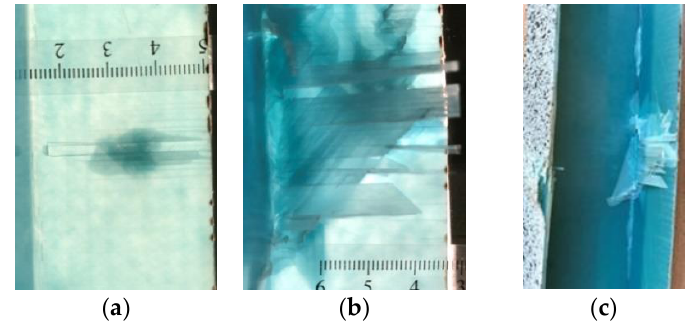
Figure 5. Impact damage before ( a ) and after ( b ) bending test, ( c ) for beam Cb2-F.